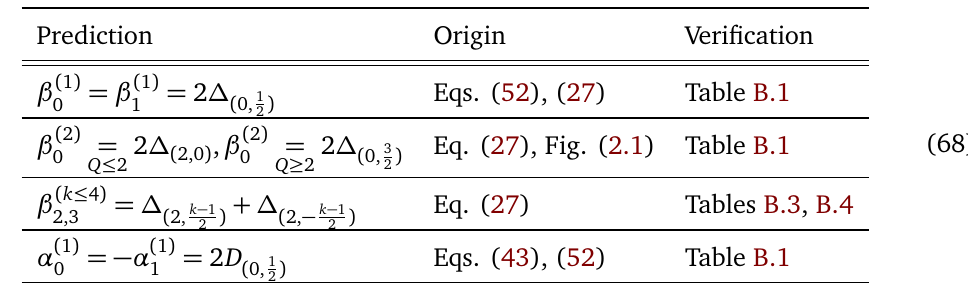
Figure 3.4: Regular parts of R 1 [ 2 ] + P ′ [ 2 ] , as functions of z . The insets give the differences. The P 0 2 3